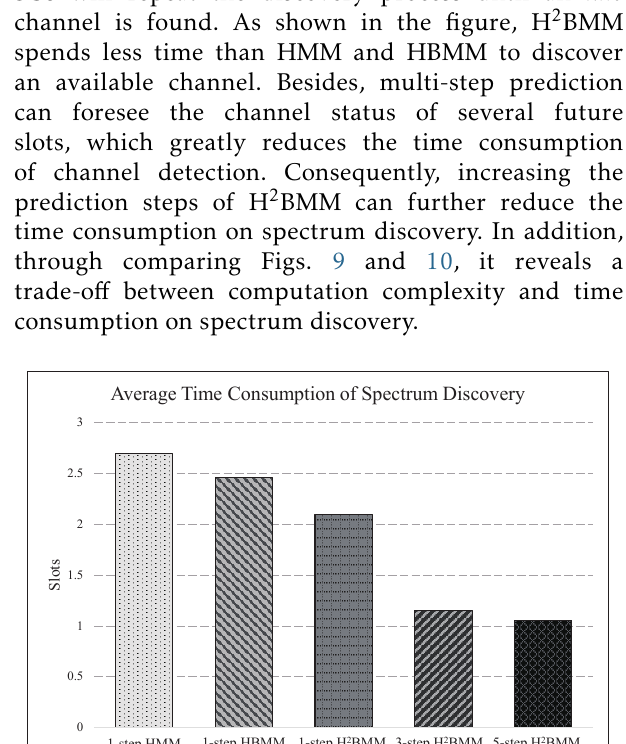
Figure 8. Miss detection possibility of HBMM (1st-order) and H 2 BMM (2nd-order)